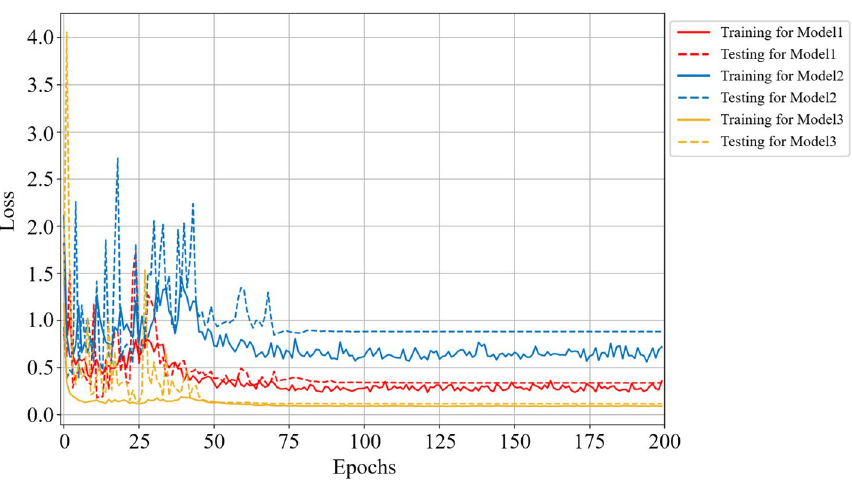
Figure 7. Comparison curves of loss performance of different models on noiseless